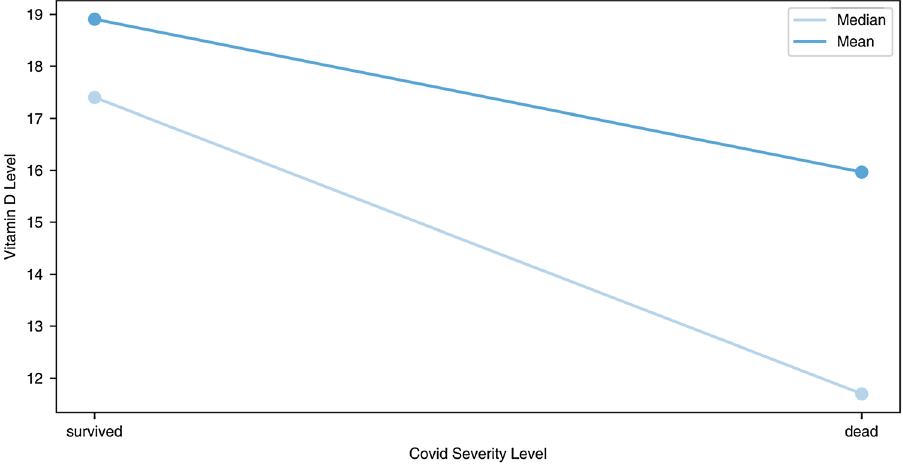
Figure 2. Vitamin D level (ng/mL) (continuous) and COVID-19 disease severity (binomial: survived,